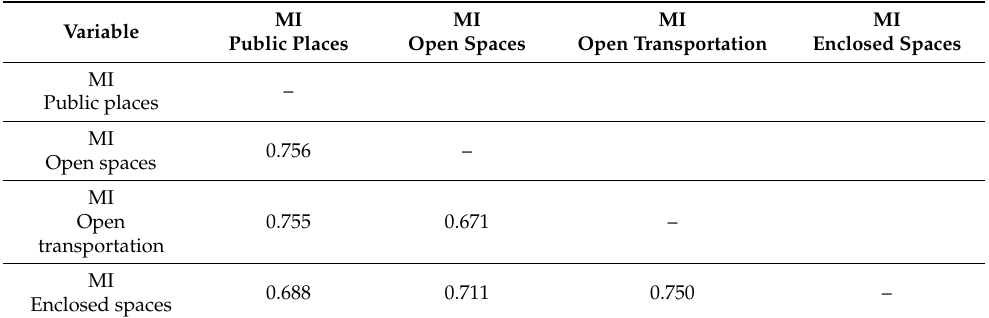
Table 3. Spearman’s correlation coefficients between Mobility Inventory for Agoraphobia subscales ( p for all < 0.001).